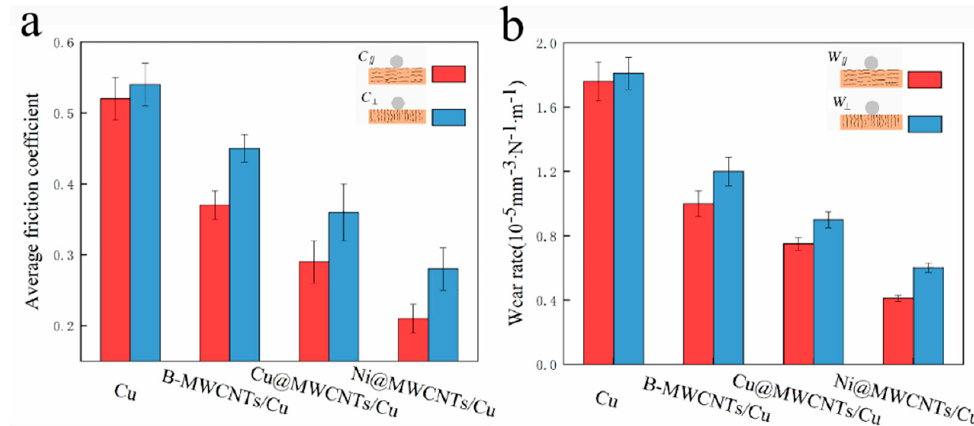
Figure 7. ( a ) Average COF, C ∥ : test plane parallel to drawing direction, C ⊥ : test plane perpendicular to drawing direction. ( b ) Wear rate, W ∥ : test plane parallel to drawing direction, W ⊥ : test plane perpendicular to drawing direction.